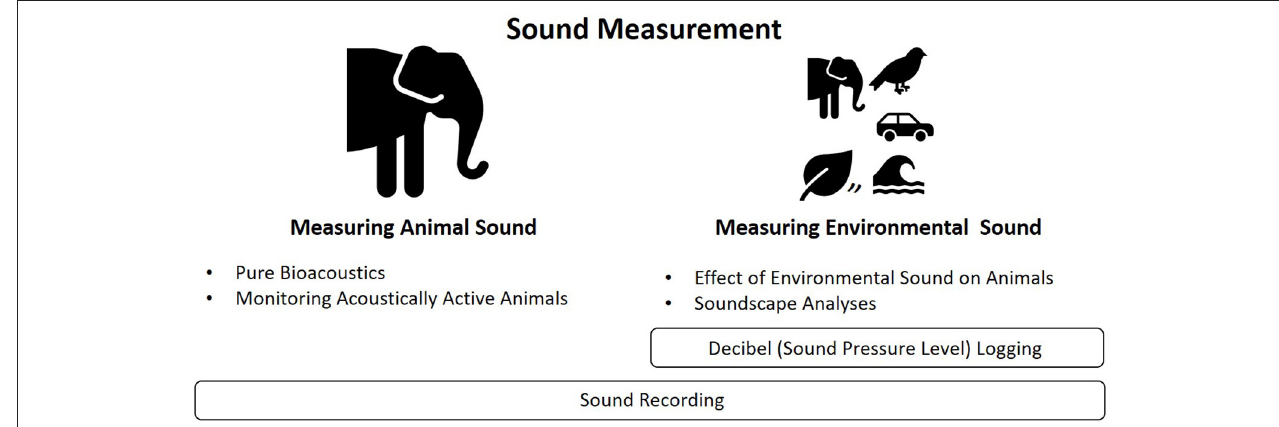
FIGURE 1 | Themes of acoustic research in